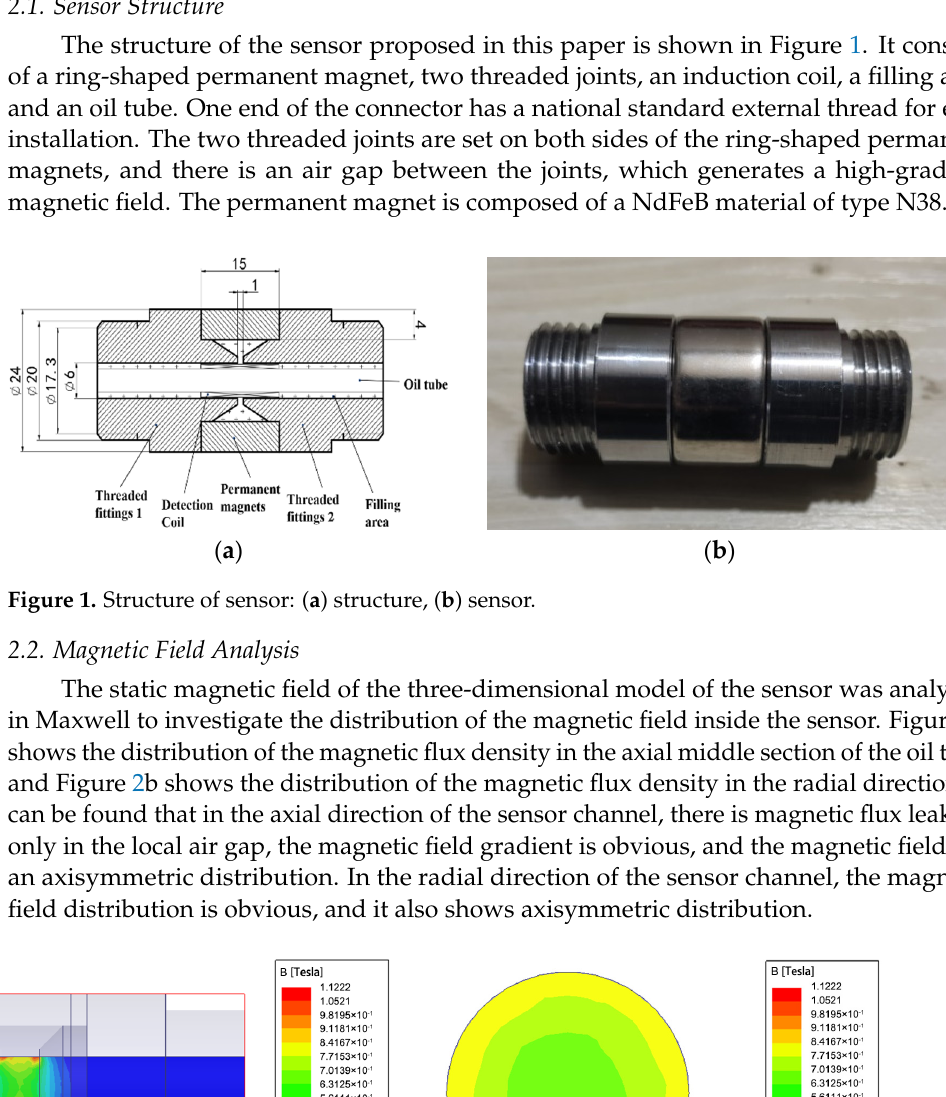
Figure 3. Magnetic flux density in the axial direction. 2.3. Detetion Principle and Inductive Voltage Model The NdFeB material has the advantages of high remanence, high coercivity and high magnetic performance, which forms a stable magnetic field inside the sensor oil tube. The sensor proposed in this paper is used for the monitoring of metal wear debris in lubricat- ing oil. When metal wear debris passes through the induction coil of the sensor, it results in a change in the internal magnetic flux, and according to Faraday’s law of electromag- netic induction, the induced voltage generated by the coil can be expressed as: 𝑢 = 𝑁 𝑙𝑖𝑚 (cid:2940)(cid:3047)→(cid:2868) Δ𝛷 Δ𝑡